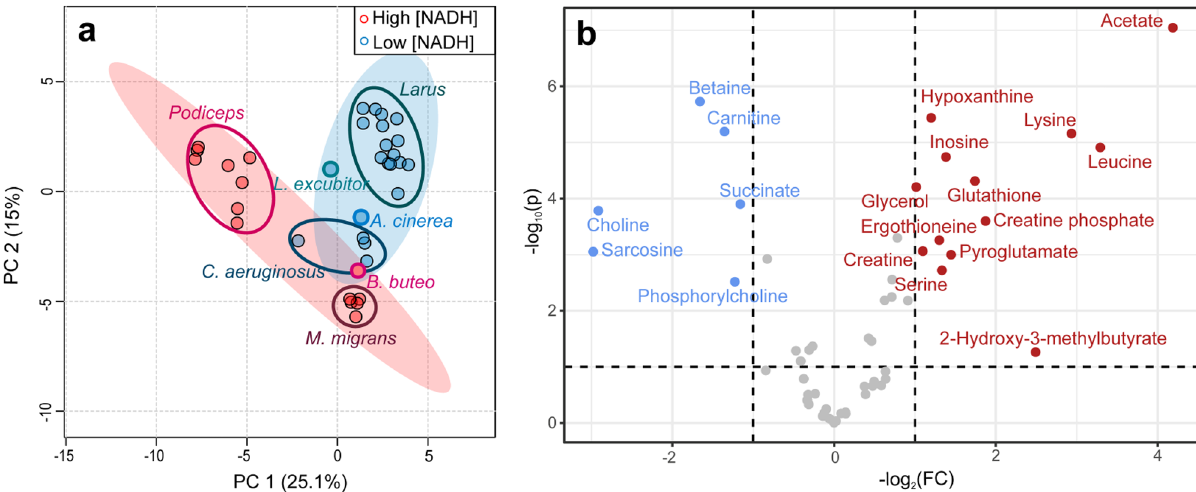
Figure 3. ( a ) Scores plot of principal component analysis (PCA) of bird lens metabolomic profiles for the groups of bird species with high and low NADH content in the lens. Filled colored ovals indicate 95% confidence regions; ( b ) Volcano plot for metabolites corresponding to the high and low NADH levels. Red and blue dots indicate significant increase (p < 0.1, FC > 2) and decrease (p < 0.1, FC < 0.5) of concentrations in the group with high NADH content, respectively.